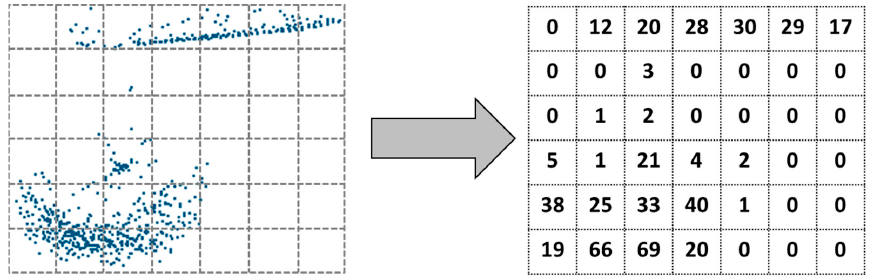
Figure 7. Generate a table that records the number of points in each grid. The image on the left is the top view of some cubic square grids, and the image on the right is the table corresponds to these cubic square grids.